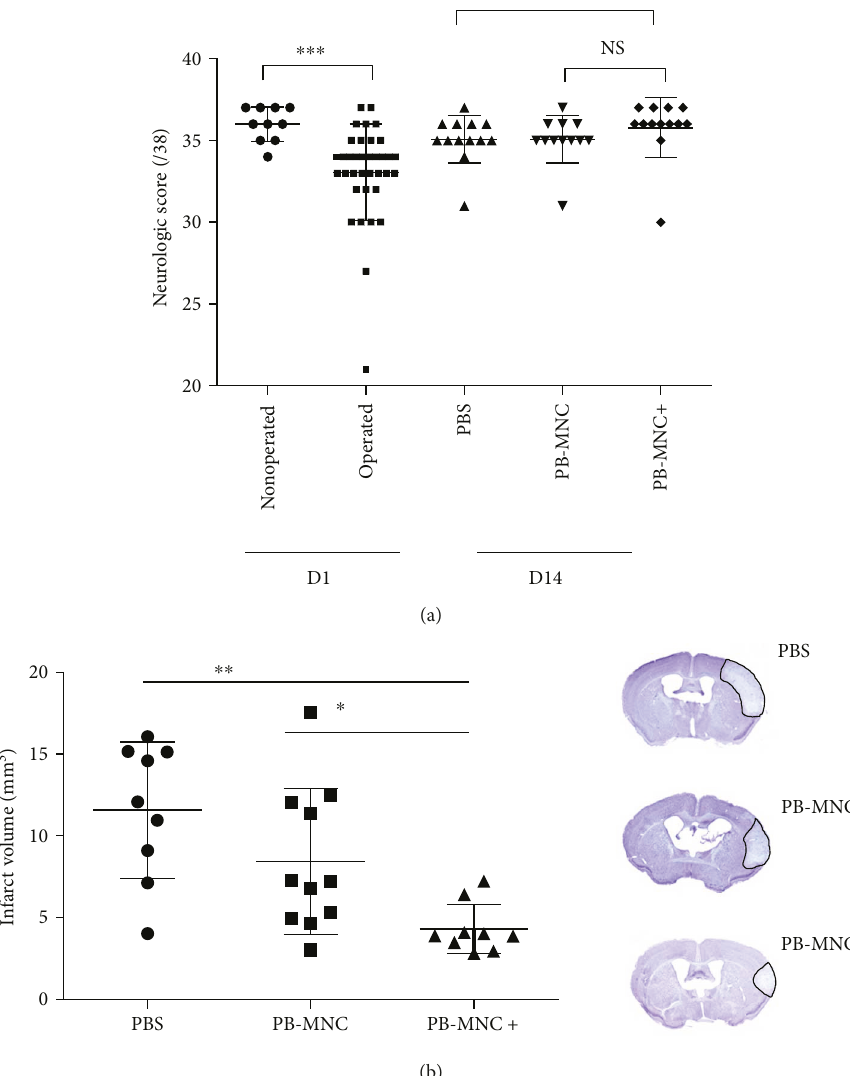
Figure 2: Neurological score is increased whereas infarct volume is decreased in mice engrafted with ephrin-B2-stimulated diabetic PB- MNC. (a) At D1, there was a signi fi cant reduction in the neurological score of operated versus nonoperated mice ( N = 36 ). At D14, a signi fi cant increase in the neurological score was detected in the PB-MNC+ versus the PBS group but not versus the PB-MNC group ( N = 12 – 13 /group). (b) At D3, there was a signi fi cant reduction in infarct volume in PB-MNC+ versus PBS and PB-MNC- treated mice ( N = 9 – 11 /group). ∗ P < 0 05 ; ∗∗ P < 0 01 ; ∗∗∗ P < 0 001